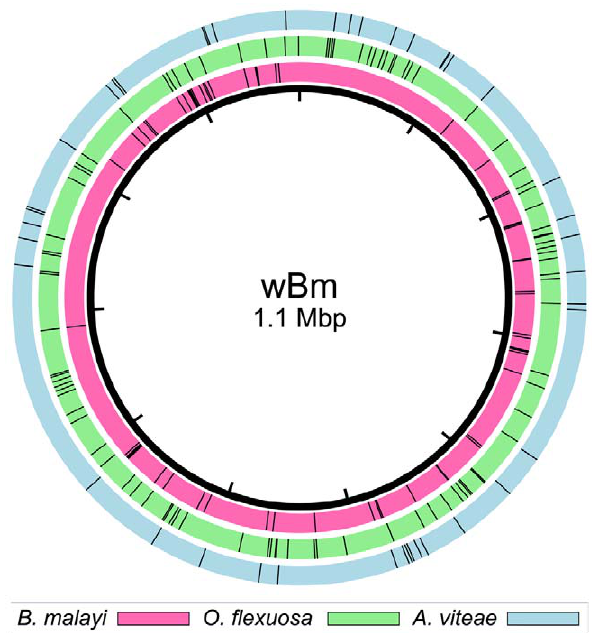
Figure 1. Mapping transferred fragments to a sequenced Wolbachia genome. Black circle represents the 1.1 Mbp genome of the Wolbachia endosymbiont of B. malayi . Tick marks in the colored outer rings indicate where a transferred DNA fragment found in the indicated species would align to the Wolbachia genome. Fragments found in the B. malayi genome were previously described by Dunning Hotopp et al. [7]. doi:10.1371/journal.pone.0011029.g001 based on the presence of Wolbachia in other filarial species and based on the propensity of Wolbachia to transfer DNA to the nuclear genomes of its hosts [7].